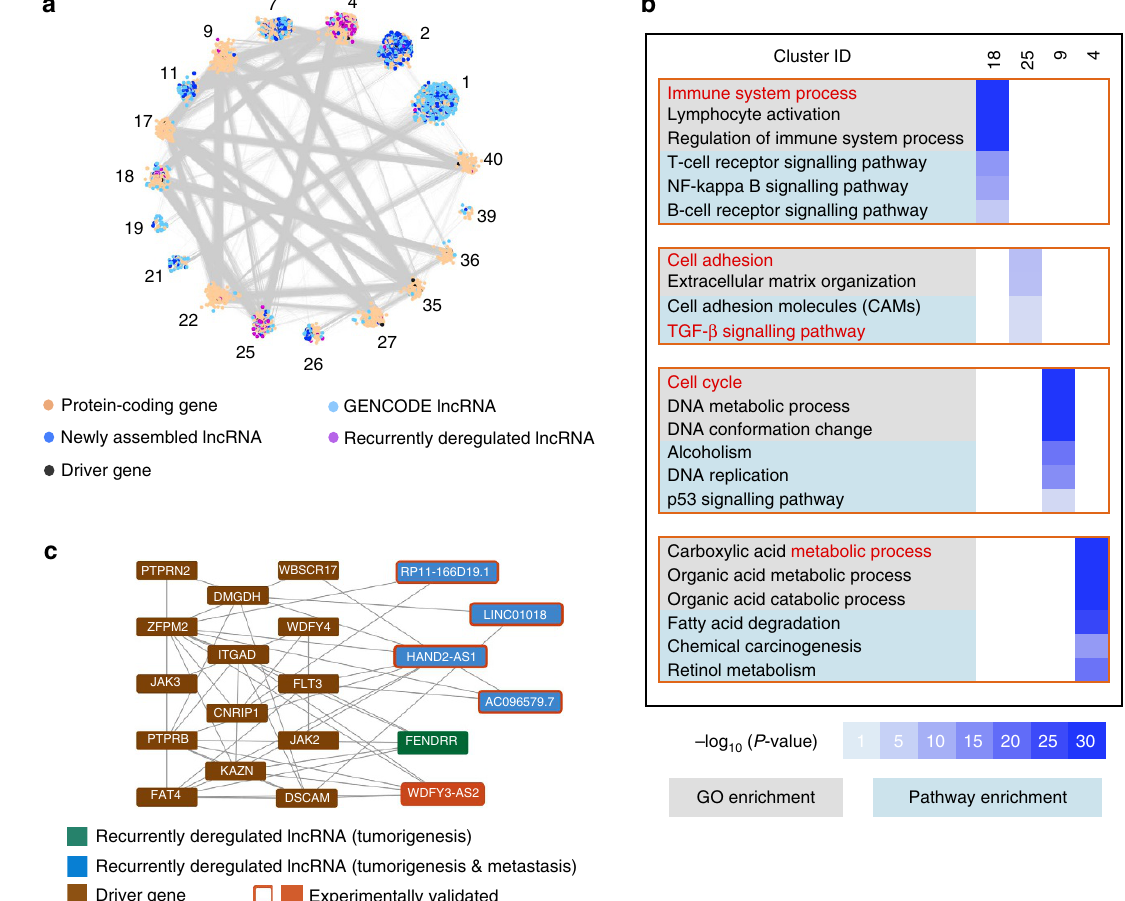
Figure 5 | Inference of potential functions for recurrently deregulated lncRNAs using a co-expression network. ( a ) Network representation of 18 selected inter-connected clusters in the coding-non-coding co-expression network. ( b ) GO and KEGG pathway enrichment for four selected clusters (4, 9, 18 and 25). Heatmap showing enrichment scores ( (cid:2) log 10 ( P value)) for GO terms and KEGG pathways in four selected clusters. The most significantly enriched GO terms and KEGG pathways are displayed. ( c ) Sub-network showing important genes/lncRNAs in cluster 25. The subnetwork depicts the relationships among four lncRNAs and liver cancer-related driver